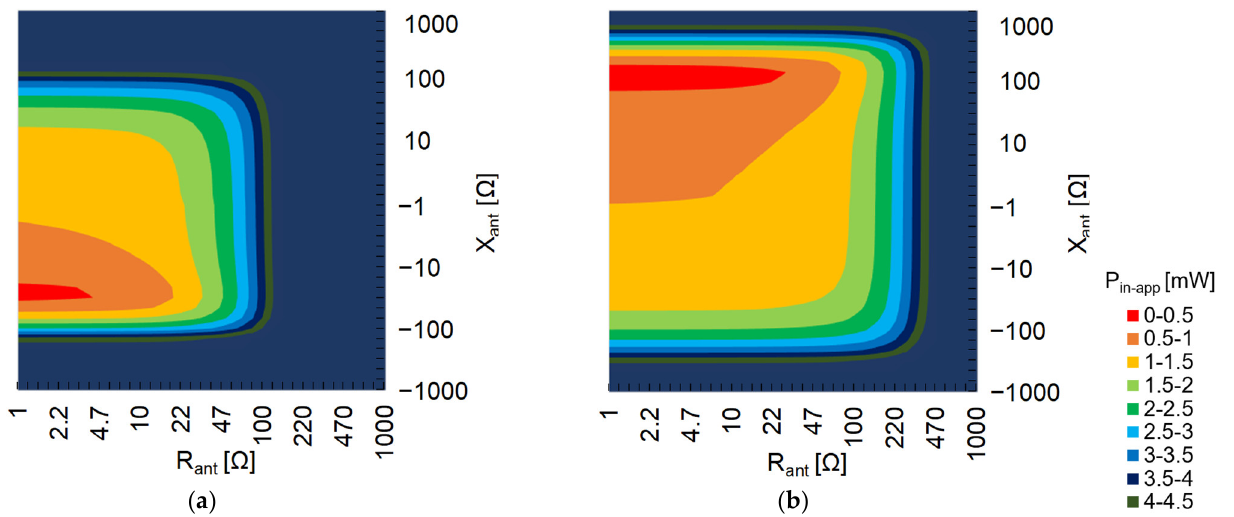
Figure 25. Change in input apparent power contour plots when is varied (VD + 10 Ω load): ( a ) C pad = 1.3 pF, ( b ) C pad = 0.3